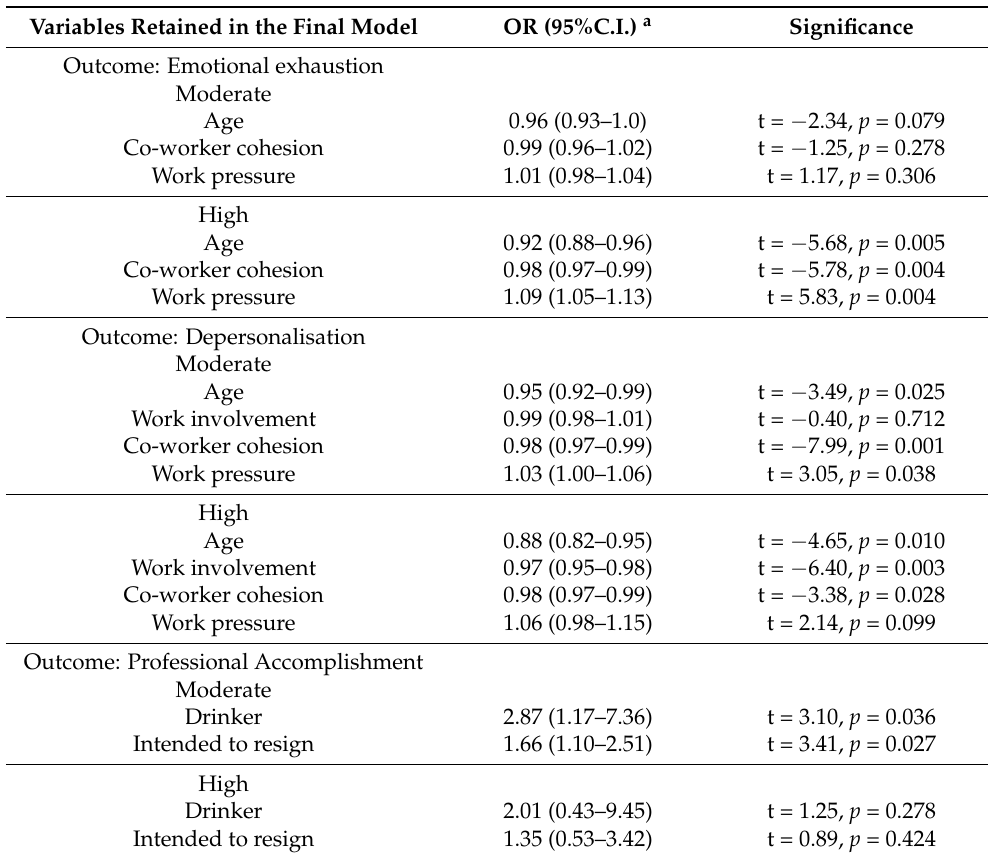
Table 3. Results obtained from the final model of the multinomial logistic regression